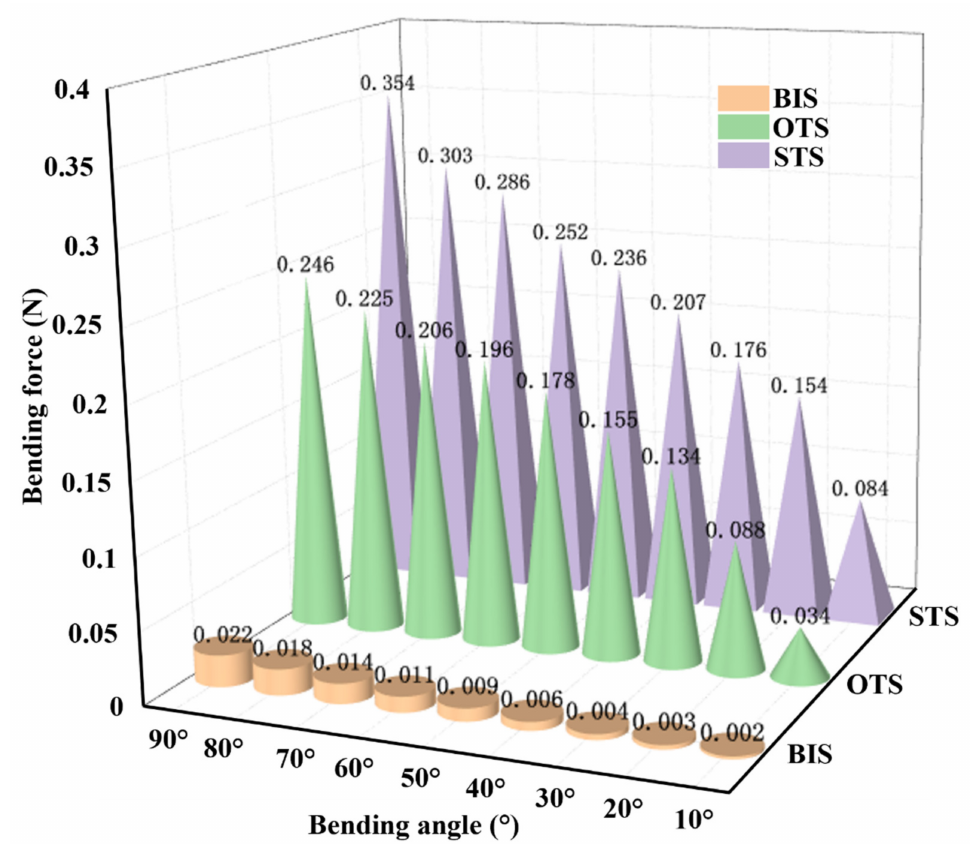
Figure 12. Stalk bending force. BIS: stalks between buds and leaves; OTS: one and two leaves interstitial stalks; STS: stalks between the second and third